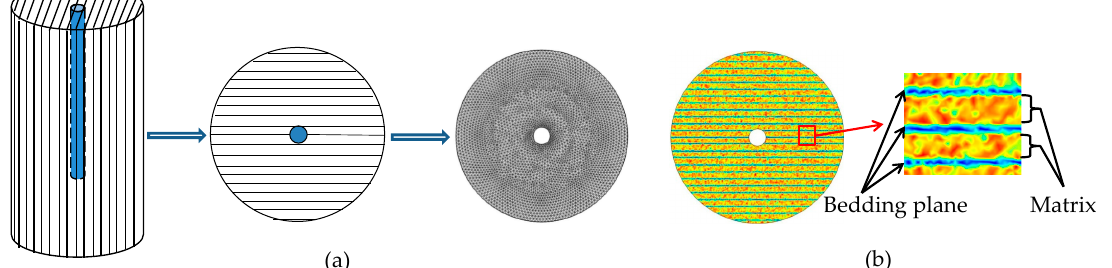
Figure 7. A computational model for the shale with a bedding angle of 90 ◦ . ( a ) Grid model with 6776 triangular elements, ( b ) Young’s modulus for shale matrix and bedding plane.